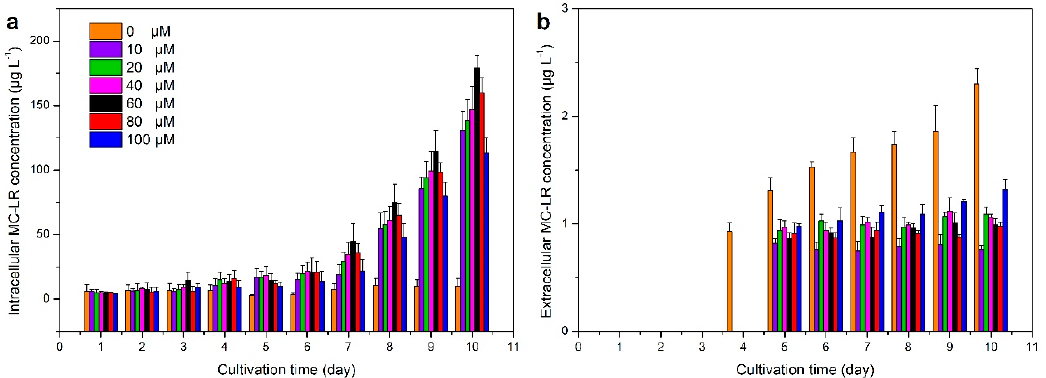
Figure 3. Intracellular ( a ) and extracellular ( b ) MC–LR concentration of M. aeruginosa ( Microcystis aeruginosa ) FACHB–905 under different iron conditions. Error bars represent the standard deviation of triplicate samples.